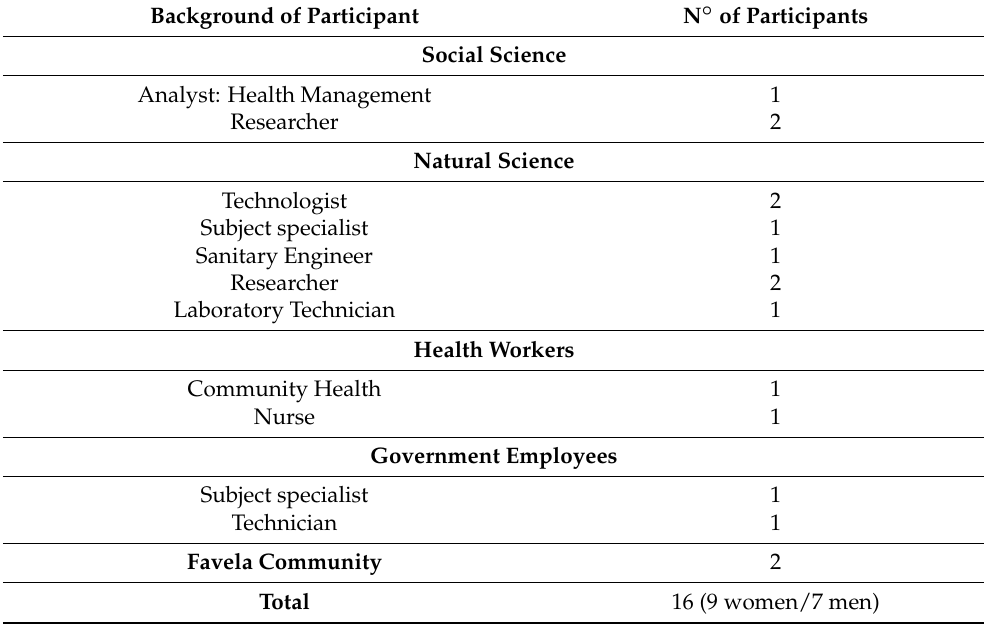
Table 1. Interviewees in the project, and an indication of specialisation areas only, in order to preserve